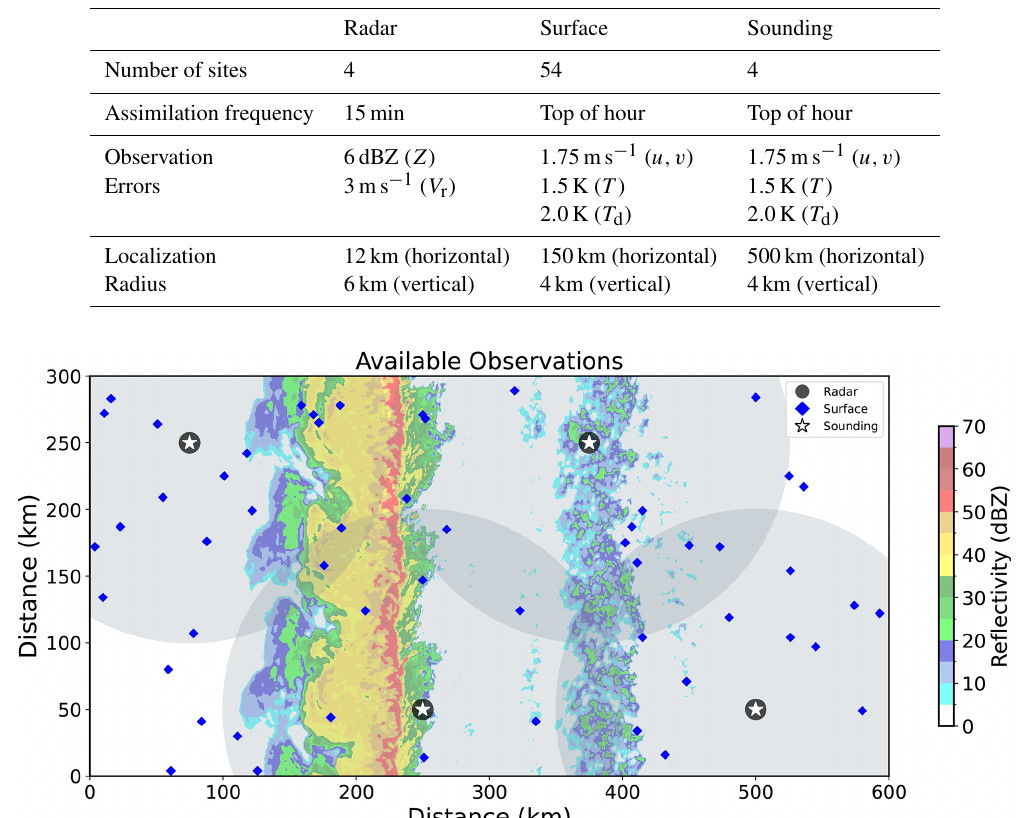
Figure 10. The experiment domain with assimilated observations plotted. Large translucent gray circles mark the scanning radius of four radars (marked by the dark circles). White stars mark the sites where soundings are launched. The 54 assimilated surface stations are marked by blue diamonds. Nature run Z at the time of the final data assimilation cycle (02:30UTC) is plotted for reference.